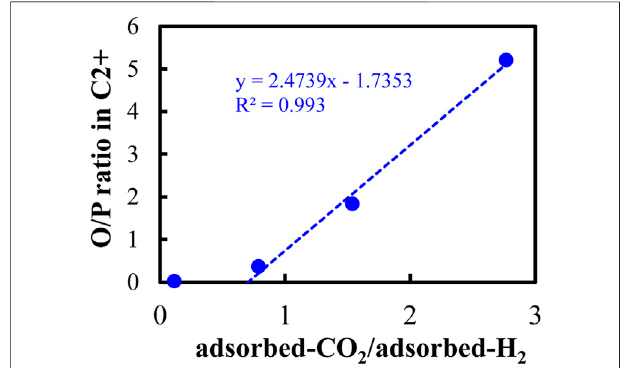
FIGURE 12 | Relationship between the ole fi n/paraf fi n ratio and the ratio of the amount of type III + IV adsorbed CO 2 over the amount of type III + IV adsorbed H 2